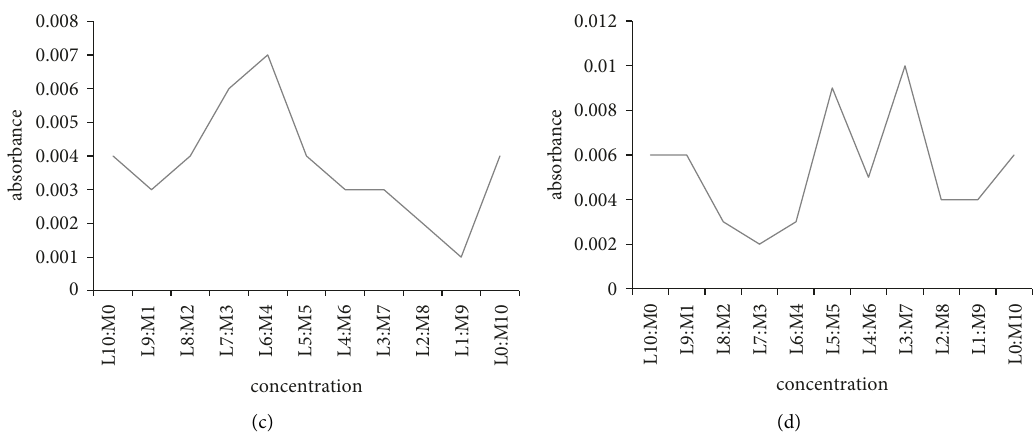
Figure 3: Stability constant of DMBH with (a) CuCl 2 .2H 2 O, (b) Cu(CH 3 COO) 2 , (c) CoCl 2 .6H 2 O, and (d) Co(NO 3 ) 2 .6H 2 O.